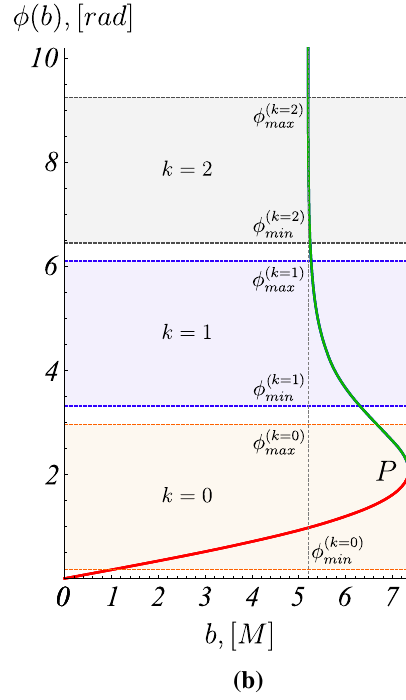
green curve is limited, possessing a single local maximum, while for the Schwarzschild solution it diverges at the impact parameter corre- sponding to the photon sphere. This leads to the possibility that two disconnected portions of the green and the red curves intersect a certain observational window, which results in the formation of two discon- nected images a given order